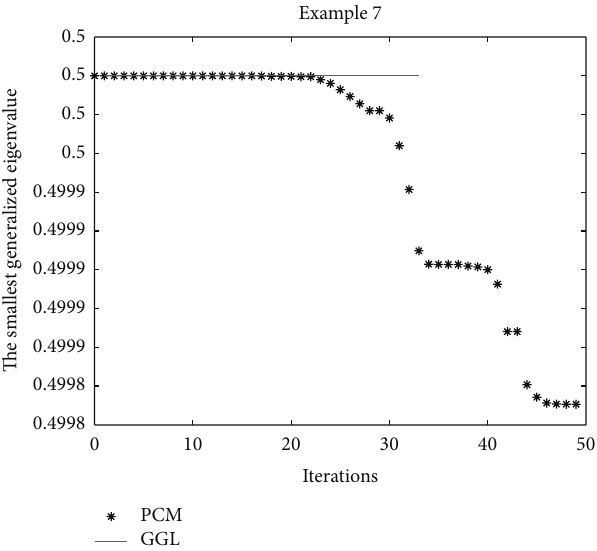
Figure 3: Numerical results of Example 7 with PCM and GGL methods.